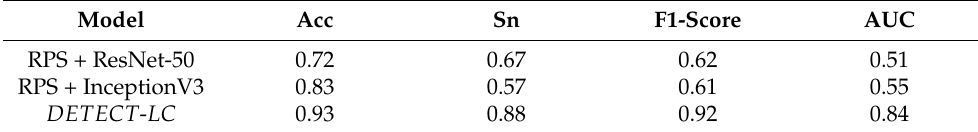
Table 10. Lung Cancer Staging Performance Evaluation on NSCLC Radio Genomics.